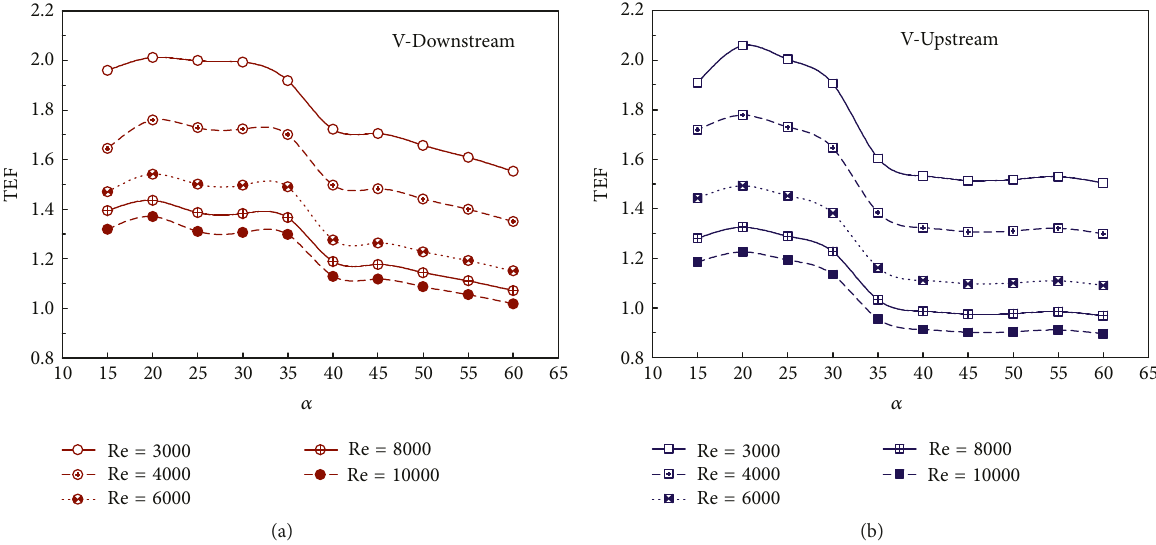
Figure 12: TEF versus 𝛼 for the square channel inserted with V-wavy plate at various Reynolds numbers of (a) V-Downstream and (b)